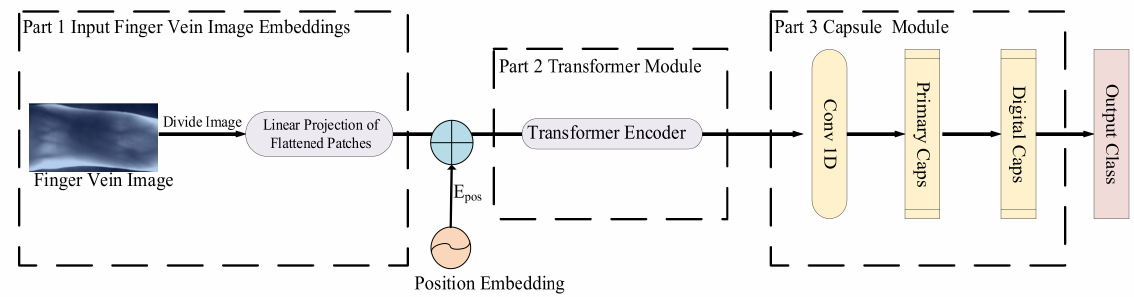
Figure 1. The overall architecture of the ViT-Cap